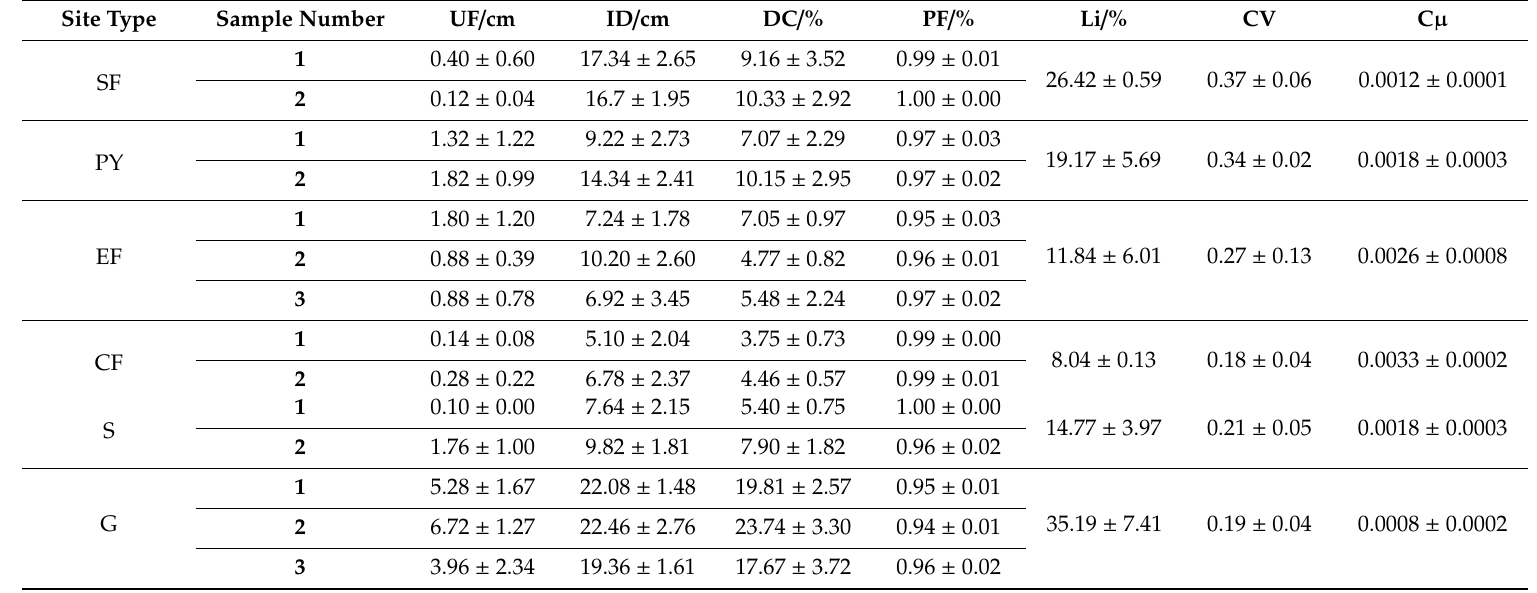
Table 4. Characteristic parameters of preferential flow variables. (G35). (average value ± standard